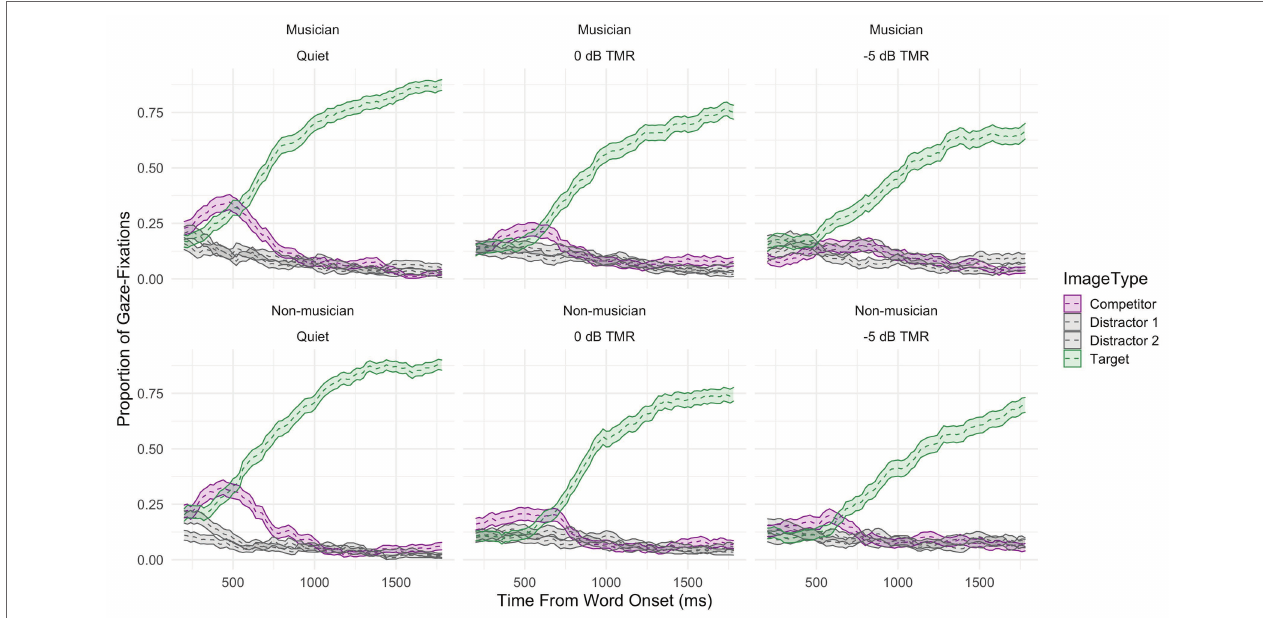
FIGURE 3 | The raw data of time course curves of gaze fixations averaged across participants and items to both the target (green), competitor (purple), and distractors (gray) shown for all conditions (from left to right: speech-in-quiet, 0 dB TMR, and − 5 dB TMR) and both groups ( top panels: musicians, and bottom panels: